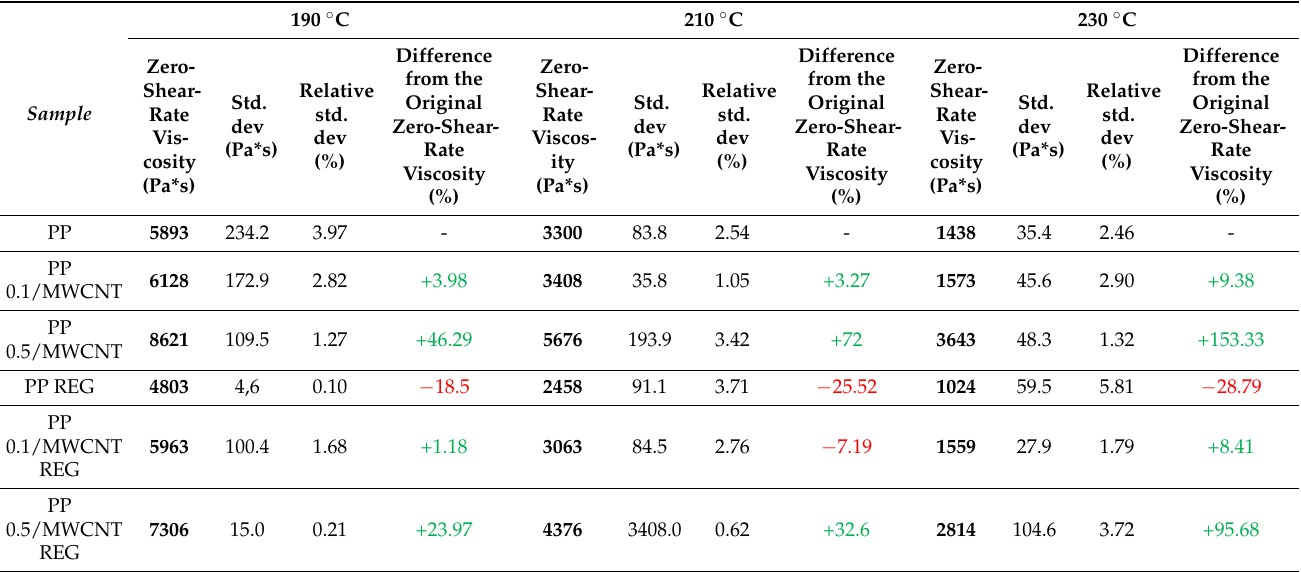
Table 3. Results of zero-shear-rate viscosity of wide temperature range of PP/MWCNT (negative changes highlighted in red, positive changes in